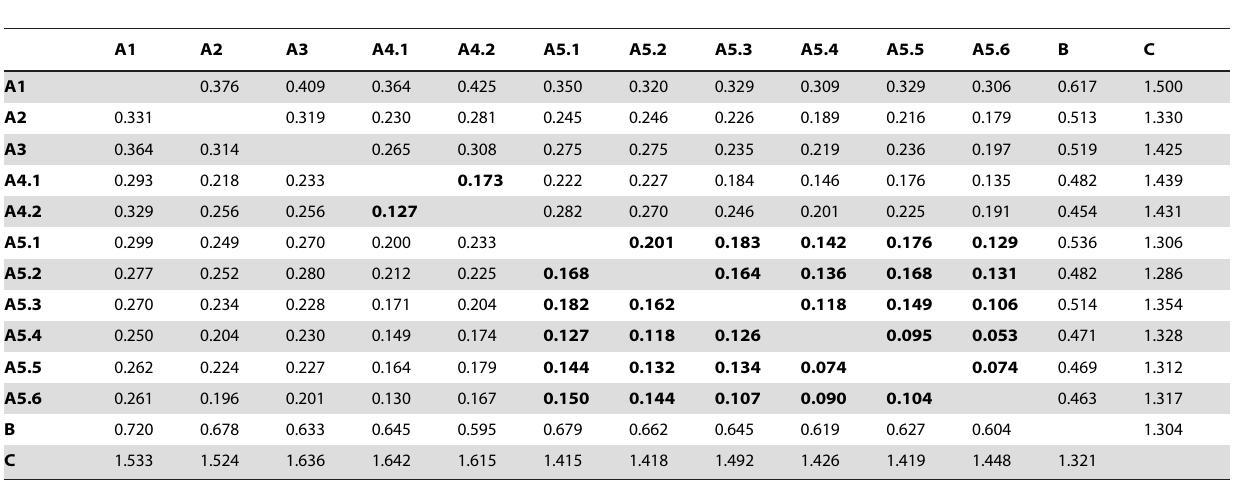
Table 2. Matrix of nucleotide and protein distances between NS1 groups, subgroups and lineages in db4535 and pdb4535,